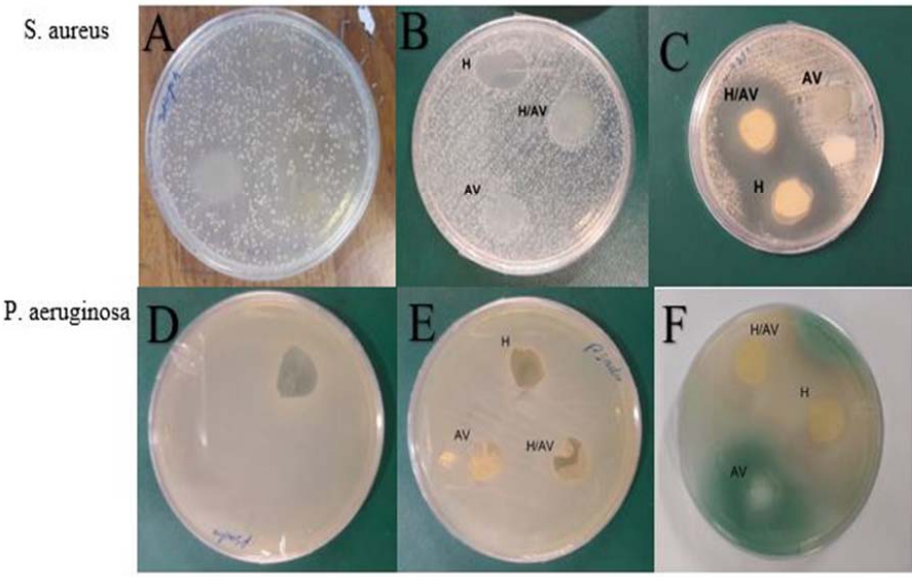
Fig. 6. Antibacterial activity of thin Figure 6 . Antibacterial activity of thin films